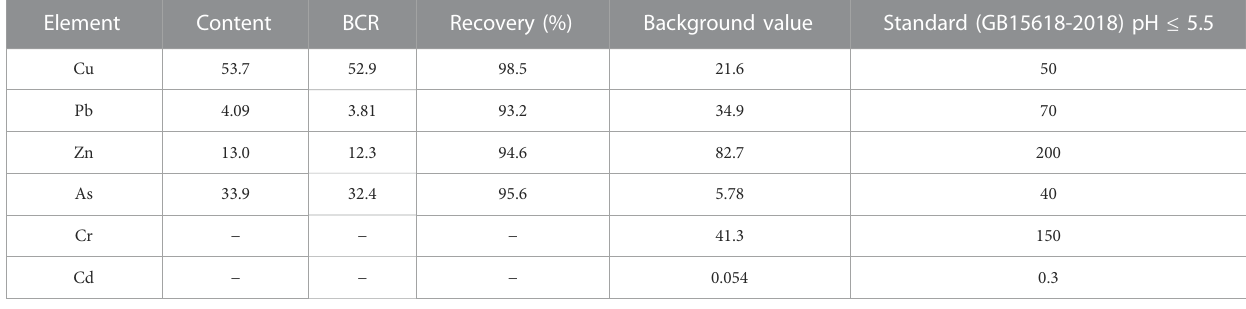
TABLE3ContentsofsixheavymetalsinthetailingsobtainedbydigestionandBCR,backgroundvaluesinFujianProvinceandnationalsoilpollutionriskscreening value (mg/kg).